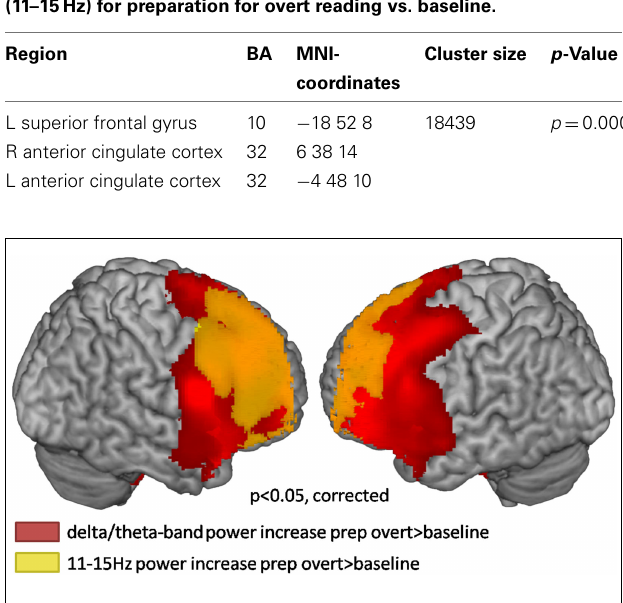
FIGURE 6 | Source localization of broadband low frequency effects during the first second of preparation for overt reading compared to baseline (cluster corrected p < 0.05). Warm colors represent power increases.